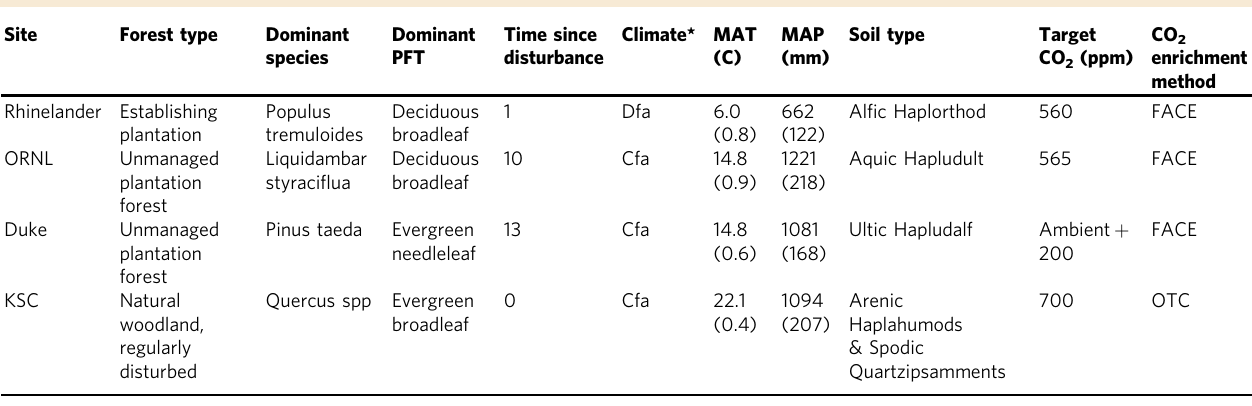
Table 1 Experiment site